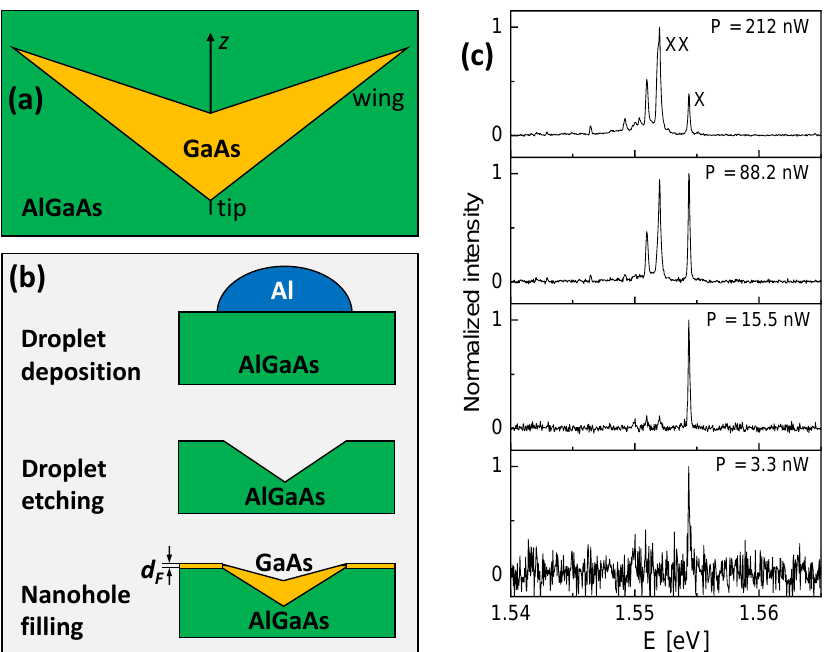
Figure 1. ( a ) Sketch of the cross section of a GaAs CSQS embedded in an AlGaAs matrix. The z -axis represents the growth direction and the direction of the applied electric field; ( b ) cross sectional sketch of the cone–shell quantum structure fabrication steps including Al droplet deposition, droplet etching, and filling of the nanoholes by deposition of a GaAs layer with thickness d F ; ( c ) PL spectra from a single GaAs CSQS with d F = 0.66 nm at varied laser power P as indicated. The exciton (X) and biexciton (XX) peaks are labeled. Here, the heterostructure is not covered with a top